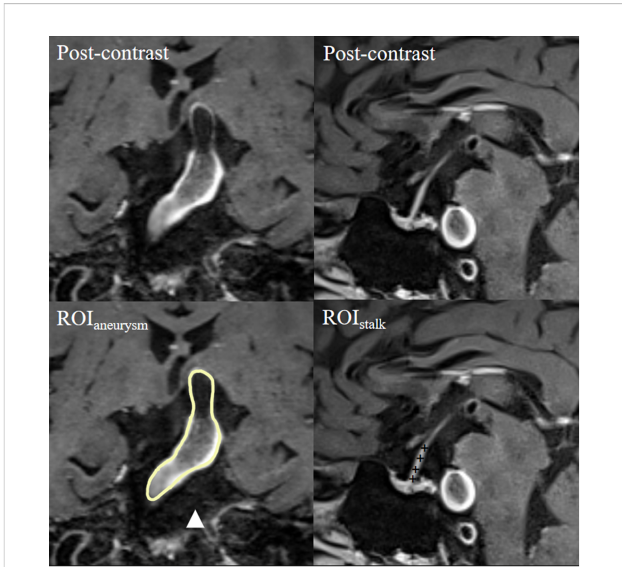
FIGURE 1 Representative case of aneurysmal wall enhancement assessment. The fi rst row shows post-contrast T1-weighted images of a basilar fusiform aneurysm and a sagittal view of the pituitary stalk. The second row shows the ROIs of the aneurysm and pituitary stalk. The average signal intensity of the ROI of the aneurysm (ROI aneurysm ) and the average signal intensity of four randomized points inside the ROI of the pituitary stalk (ROI stalk ) were measured. CR stalk was calculated as the contrast ratio of the signal intensity of ROI aneurysm to ROI stalk . CR, contrast ratio; ROI, region of